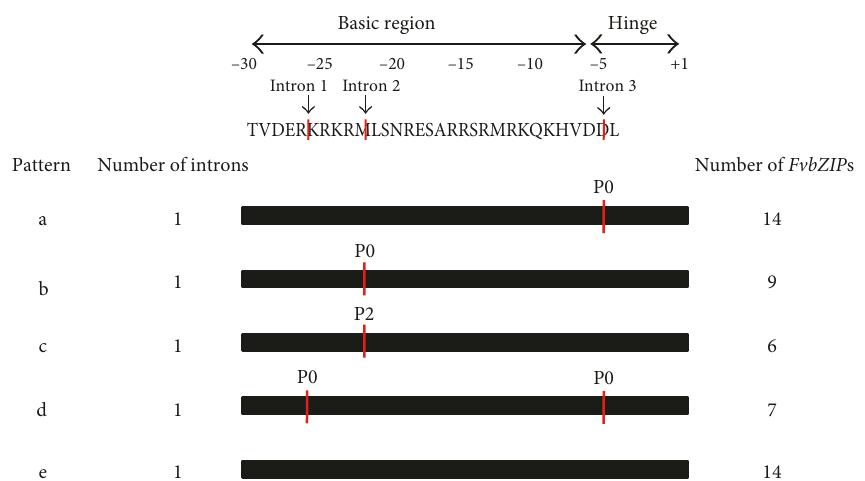
Figure 2: Intron patterns (a – e) within the basic and hinge regions of bZIP proteins. P0 and P2 stand for the intron splicing phase. P0 means splicing occurred after the third nucleotide of the codon, and P2 means splicing occurred after the second nucleotide. The black bars represent the sequence of the basic and hinge regions. The vertical lines denote the positions of intron splicing